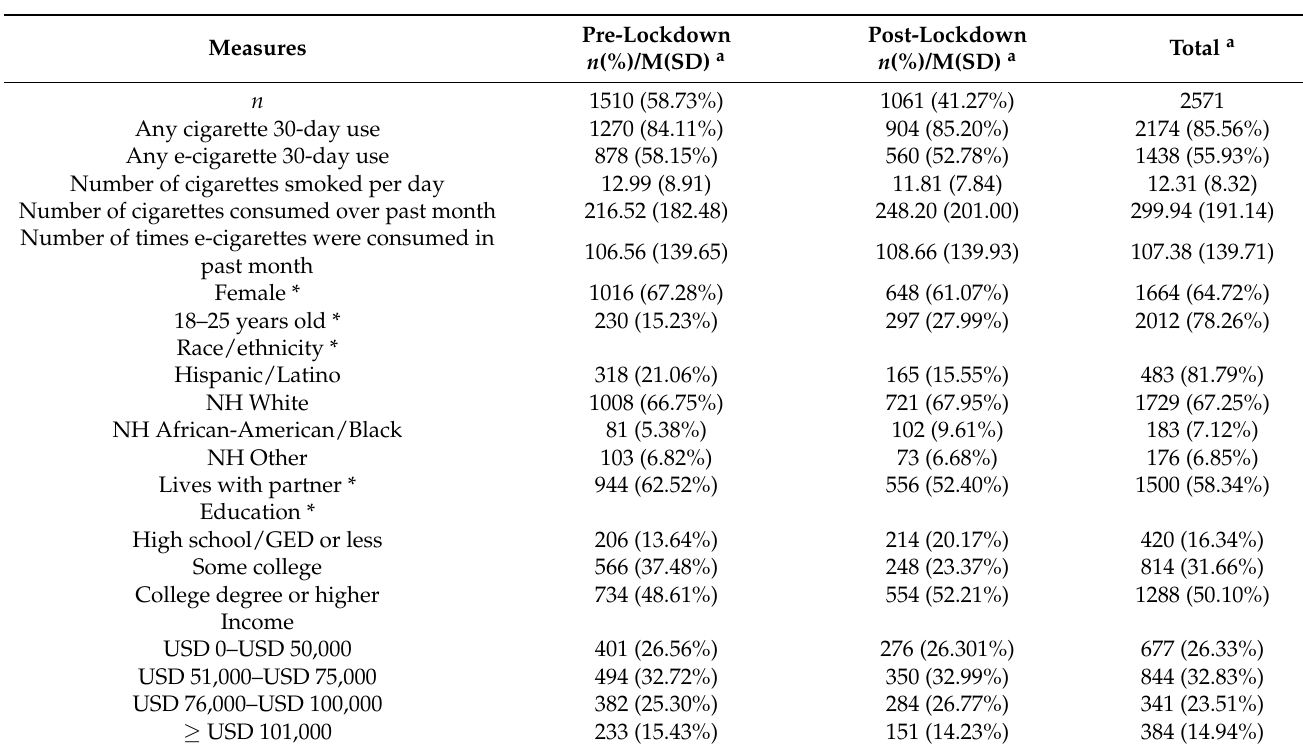
Table 1. Sample characteristics, n =